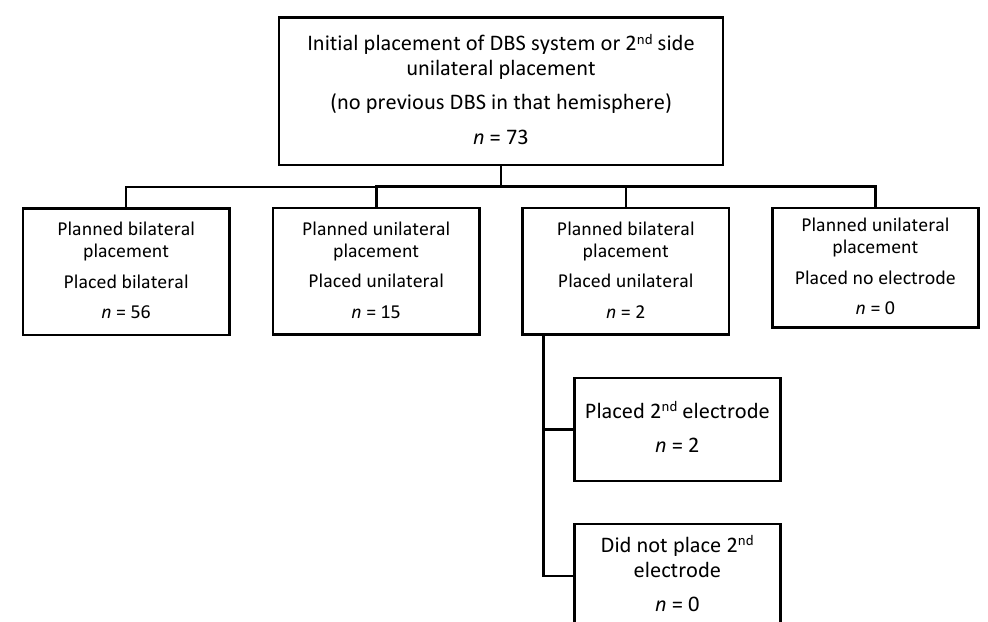
Figure 1. Unilateral versus bilateral placement in included patients.